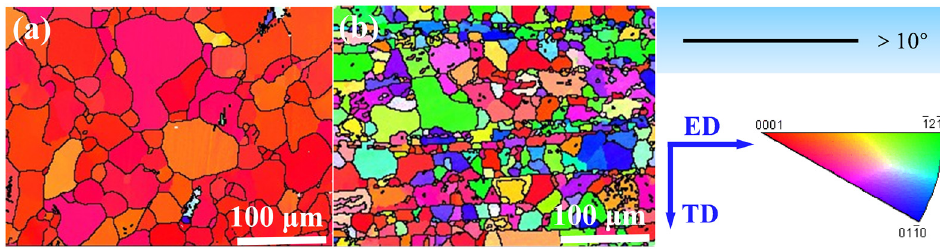
Figure 6. The IPFs results of bulk Mg and 0.5 wt.% CNTs/Mg composites on the ED-TD plane. ( a ) bulk Mg; ( b ) CNTs/Mg composites.